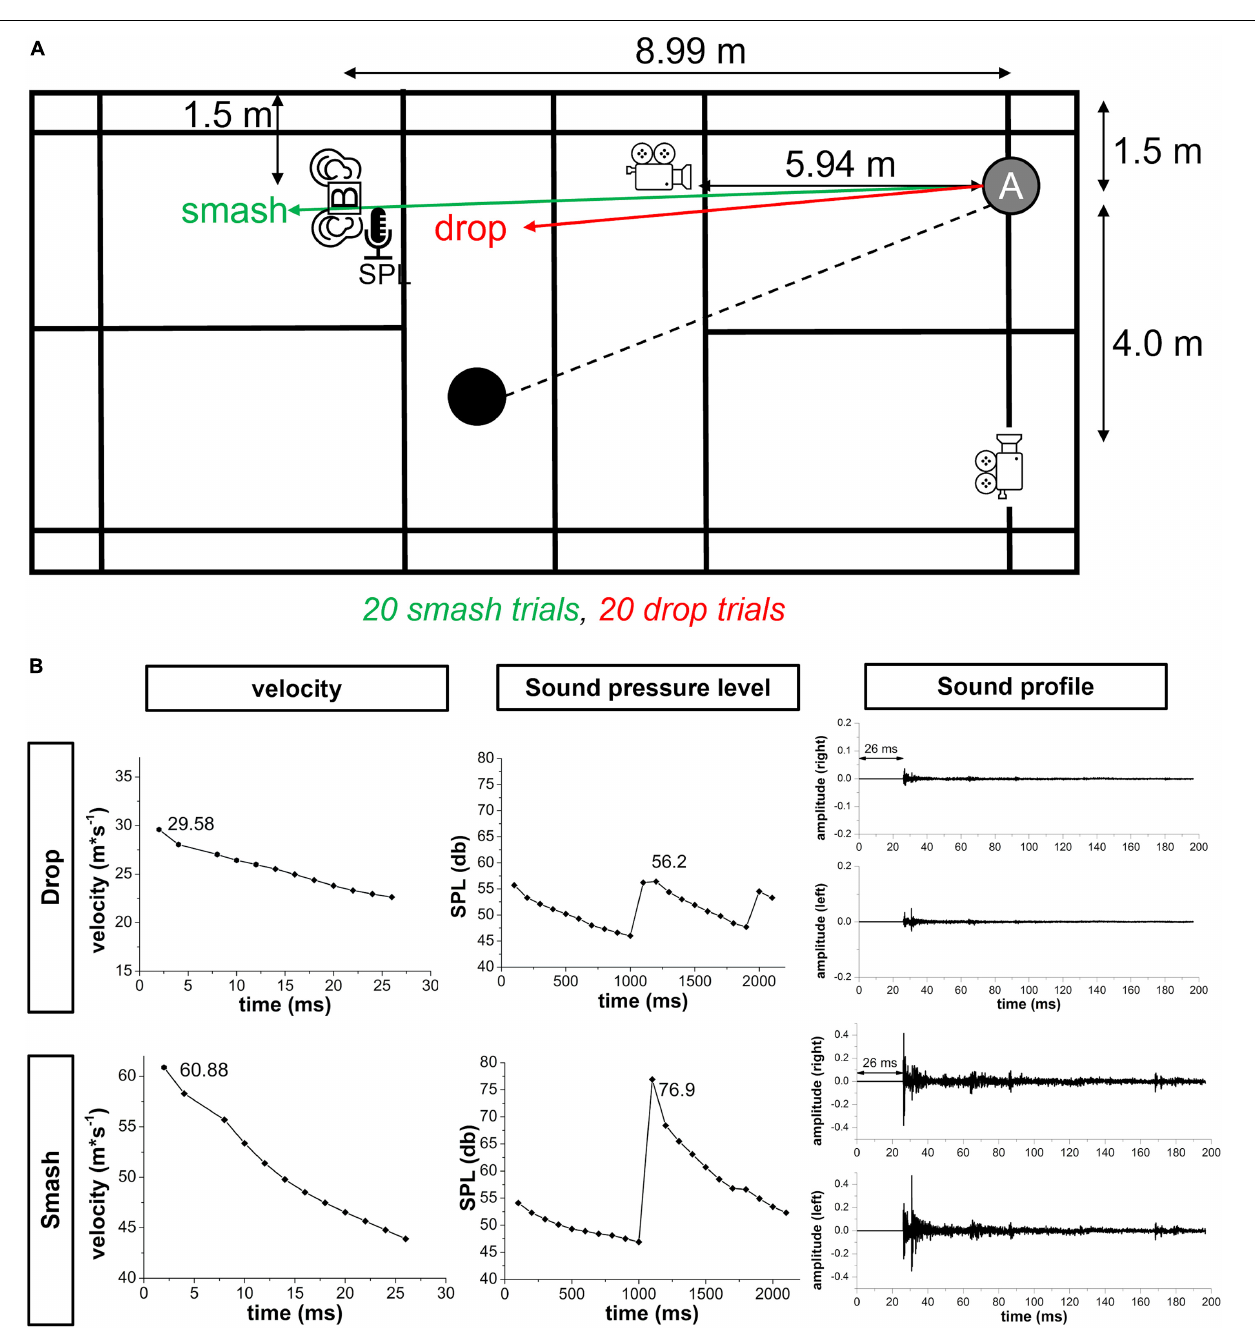
FIGURE 1 | (A) Overview of the setup for the recording phase on the badminton court. Athletes played 20 smash and 20 drop strokes in a randomized order. High-speed cameras recorded the ball trajectory in the frontal and sagittal plane. The sound pressure level and binaural sound profile were measured using a sound level meter [SPL] and binaural microphones [B]. (B) Representative velocity sound pressure level and sound profile data of one participant for a smash and drop stroke that formed the basis for creating the visual and auditory stimuli in the reaction experiment. Note: the sound profile already includes the 26 ms silent period that account for the delay in auditory information transmission. Further, the scaling for smash and drop velocity is